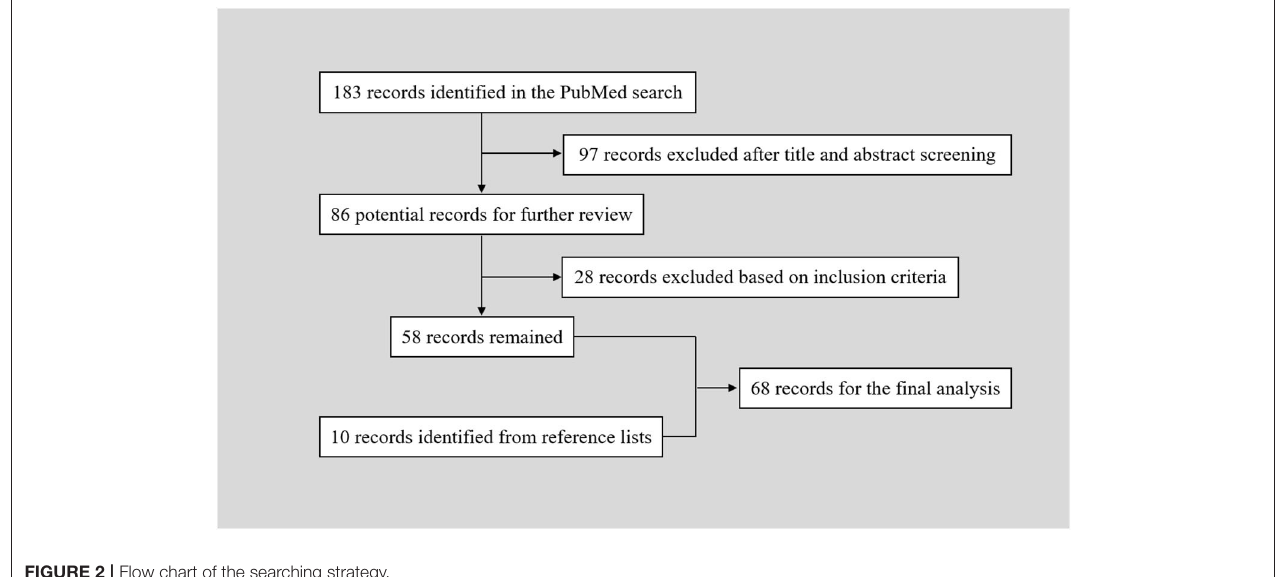
FIGURE 2 | Flow chart of the searching strategy.